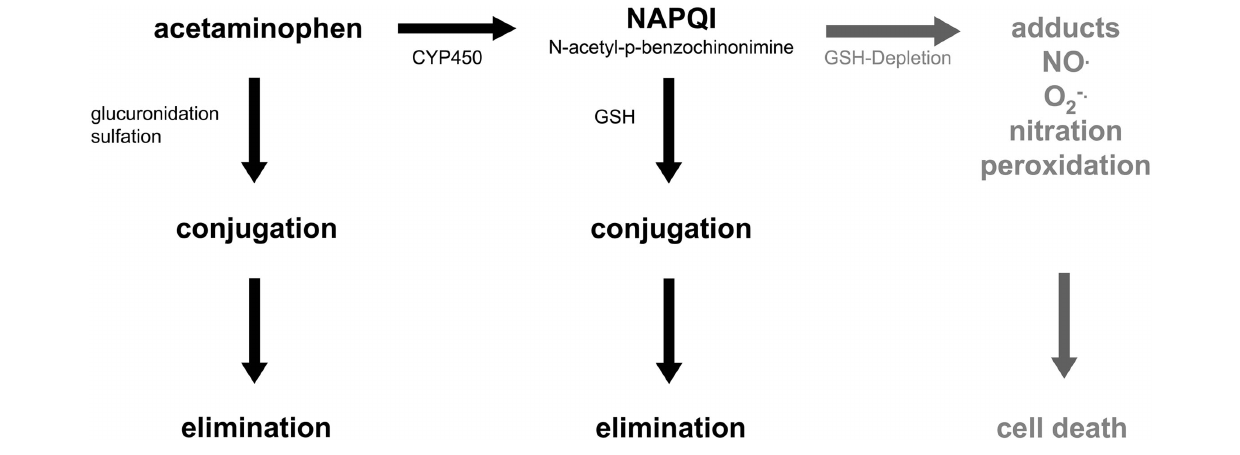
FIGURE 1 |Acetaminophen and hepatotoxicity. Acetaminophen (paracetamol) is detoxified in the liver by conjugation or cytochrome P450-dependent oxidation followed by conjugation to glutathione